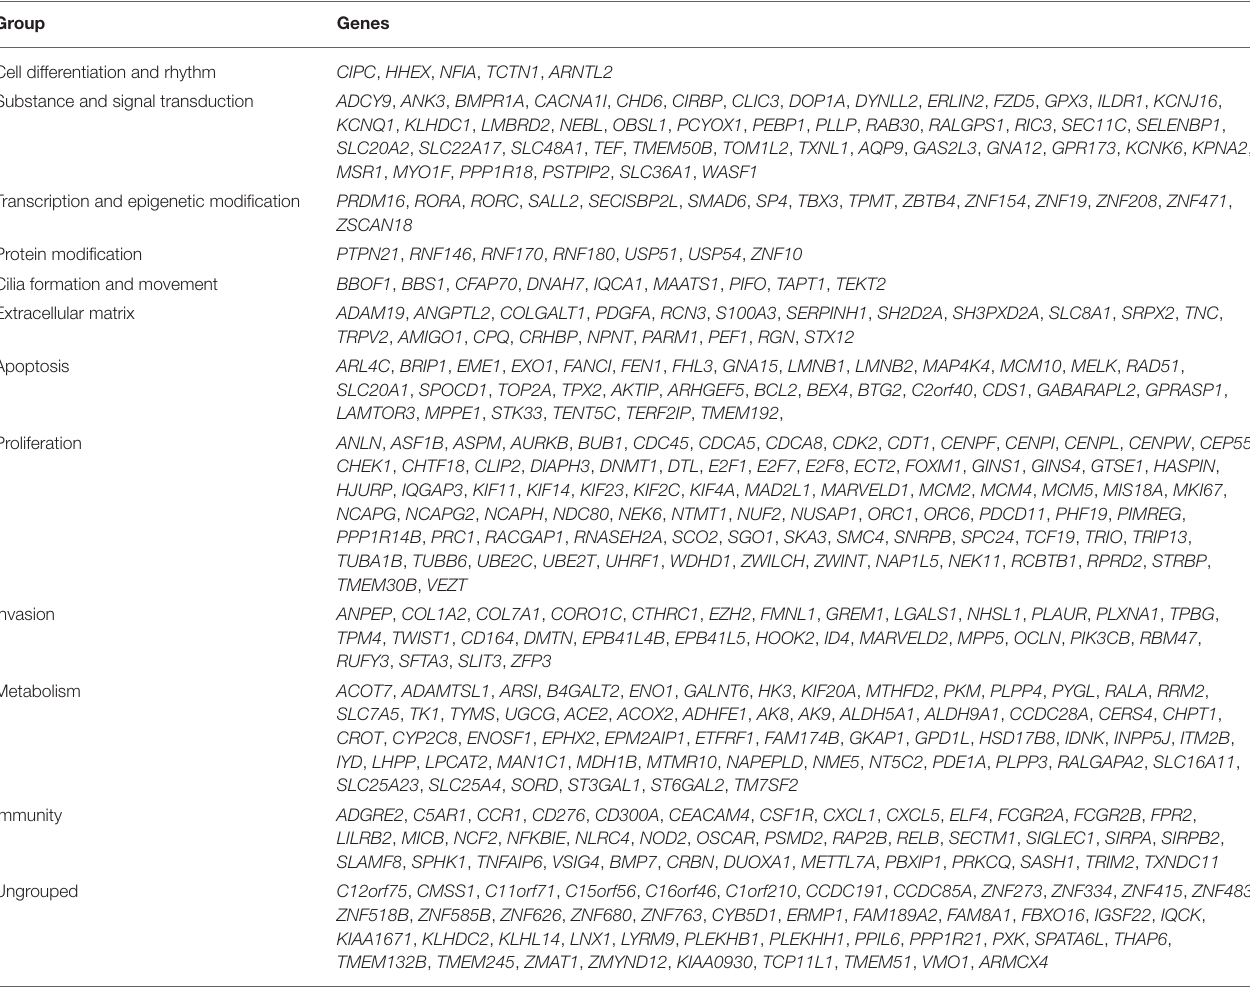
TABLE 1 | Function based differential gene grouping.